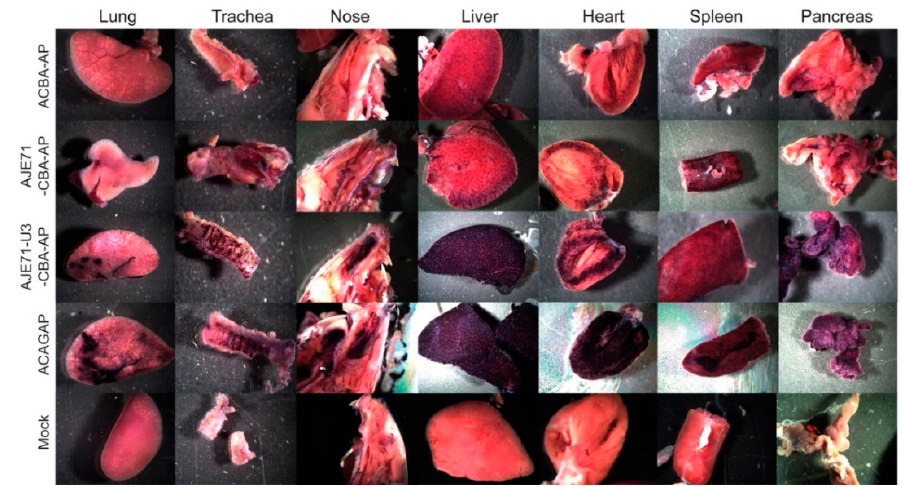
Figure 4. Representative gross images of tissues stained to indicate the presence of human placental alkaline phosphatase reporter gene expression from mice transduced with various JE / CBA constructs. AAV vectors were administered to mice by three different routes of administration concurrently: intravenous (2 × 10 10 vg), intraperitoneal (8 × 10 10 vg), and intranasal (1 × 10 10 vg) to determine relative promoter activity. Mice were euthanized 4 weeks post vector administration and tissues stained for human alkaline phosphatase reporter gene (hPLAP) expression.